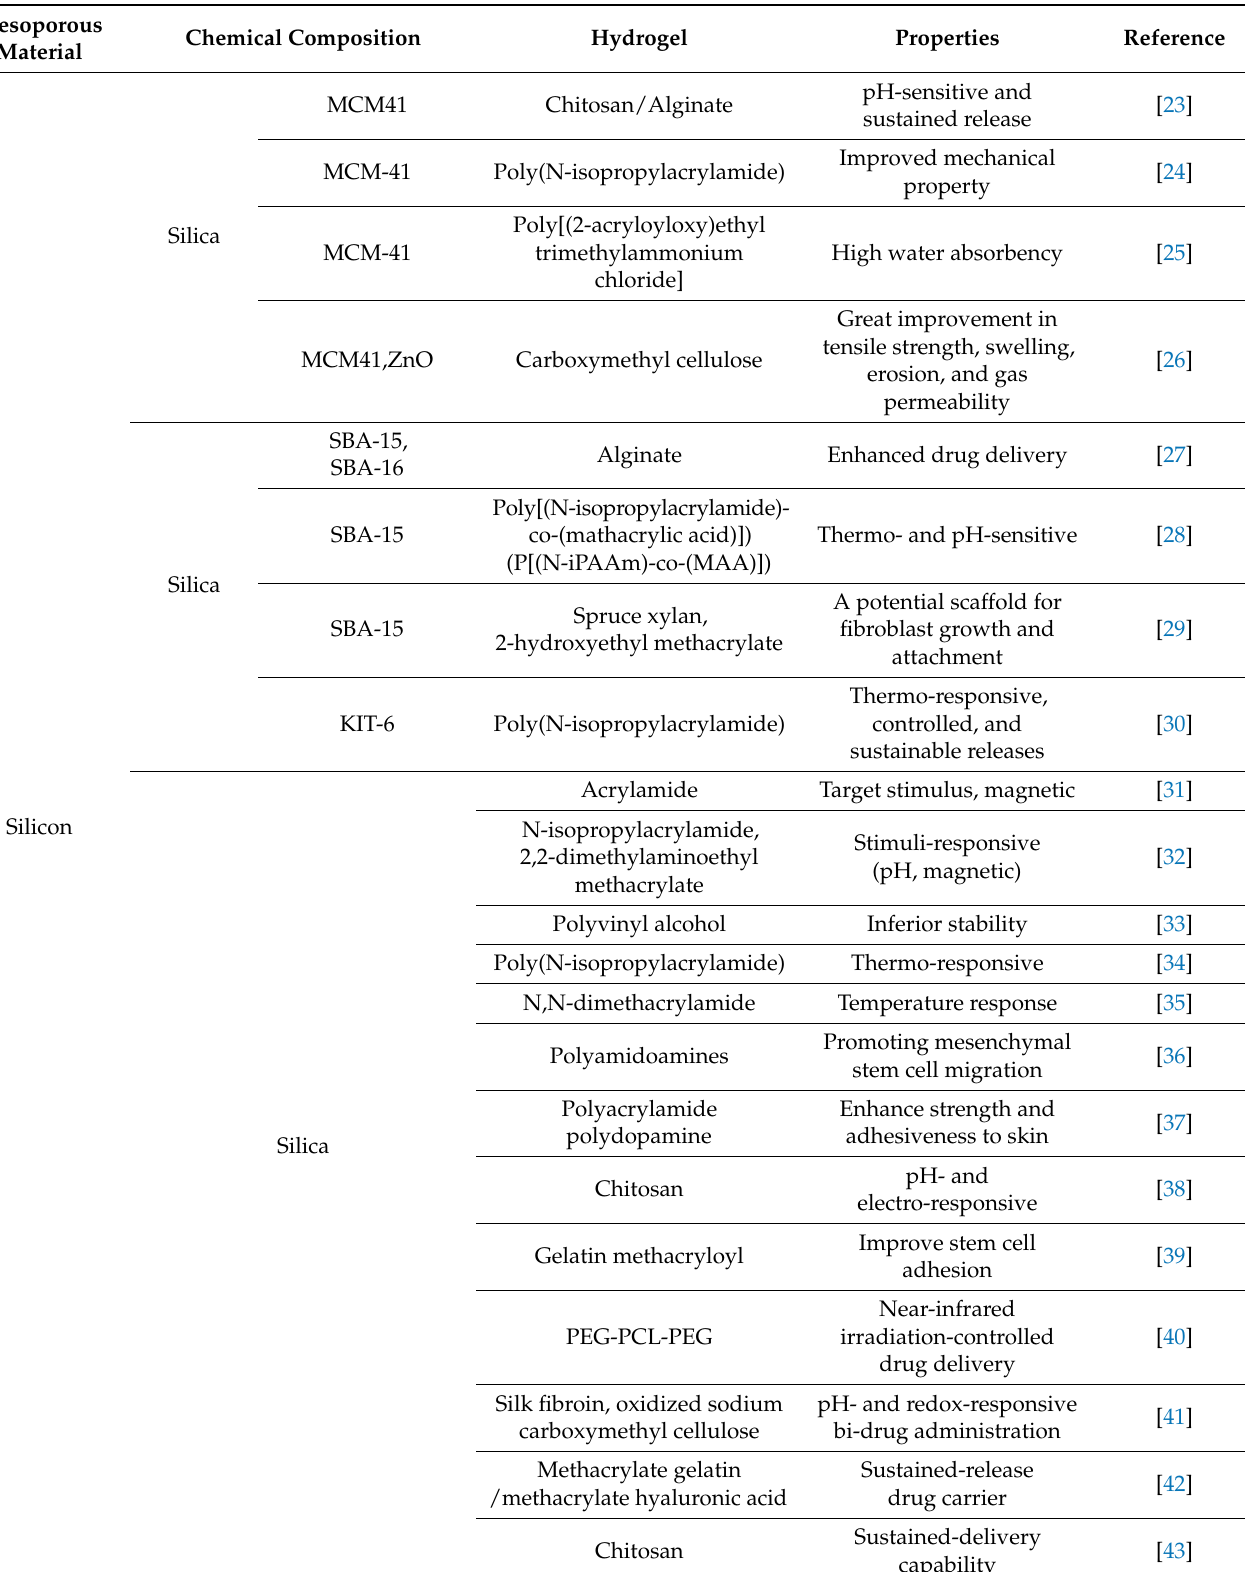
Table 1. Classification of mesoporous material-loaded composite